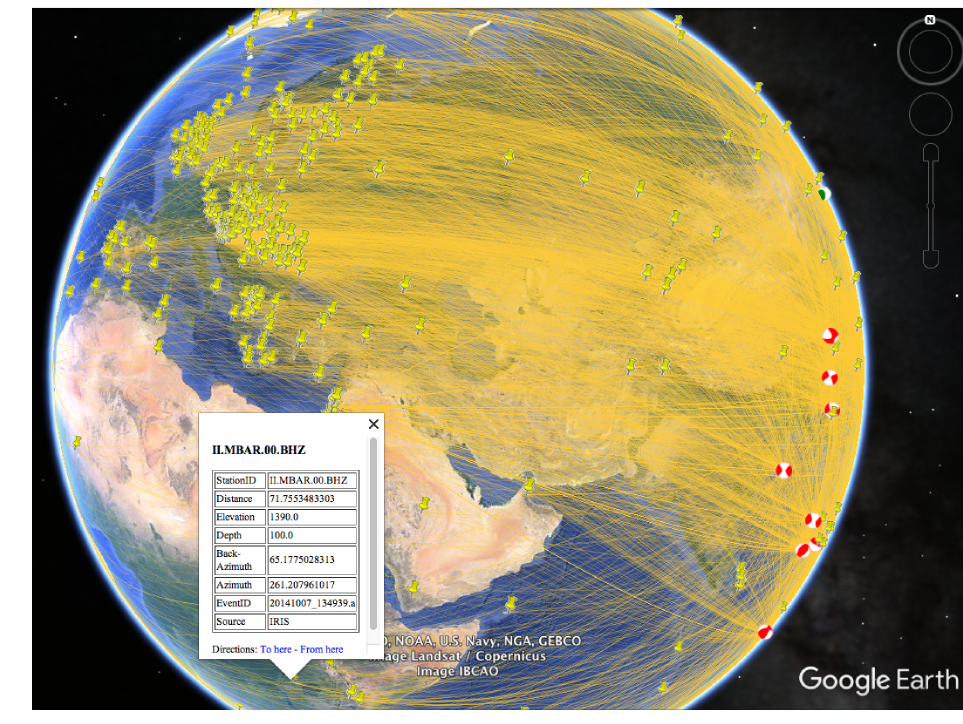
Figure 4. obspyDMT --datapath event_based_dir --local --plot_ev --plot_focal --plot_sta --plot_ray --create_kml Plot of the contents of the --datapath event_based_dir that contains the Indonesian example data set generated in Sects. 3.1 to 3.4. --local specifies that the existing, local waveform holdings should be plotted, rather than contacting the data centers anew. Sixteen earthquake locations are plotted as beach balls; stations featuring BHZ channels are indicated by yellow markers. Waveforms were retrieved from three data centers (IRIS, ORFEUS,